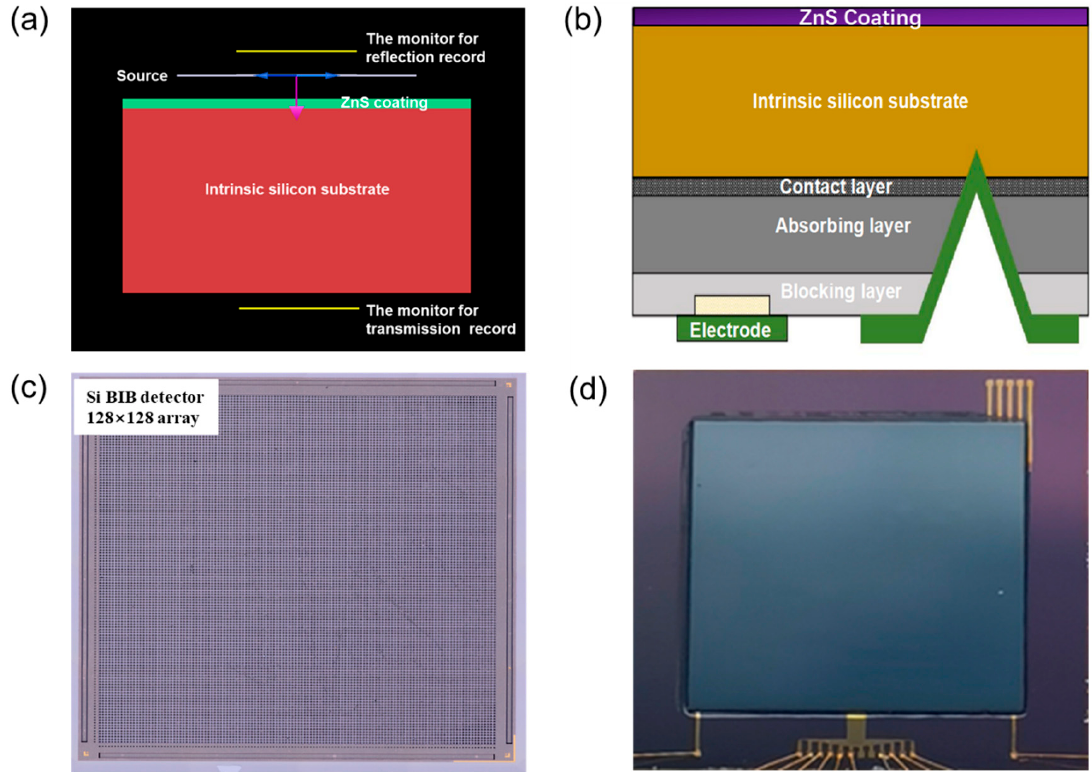
Figure 1. ( a ) Schematic diagram of ZnS/Si model. ( b ) The structure of the back-illuminated Si-based BIB detector integrated with ZnS coating. ( c ) Optical micrograph of the Si-based BIB detector. ( d ) Photo image of the packaged BIB detector.